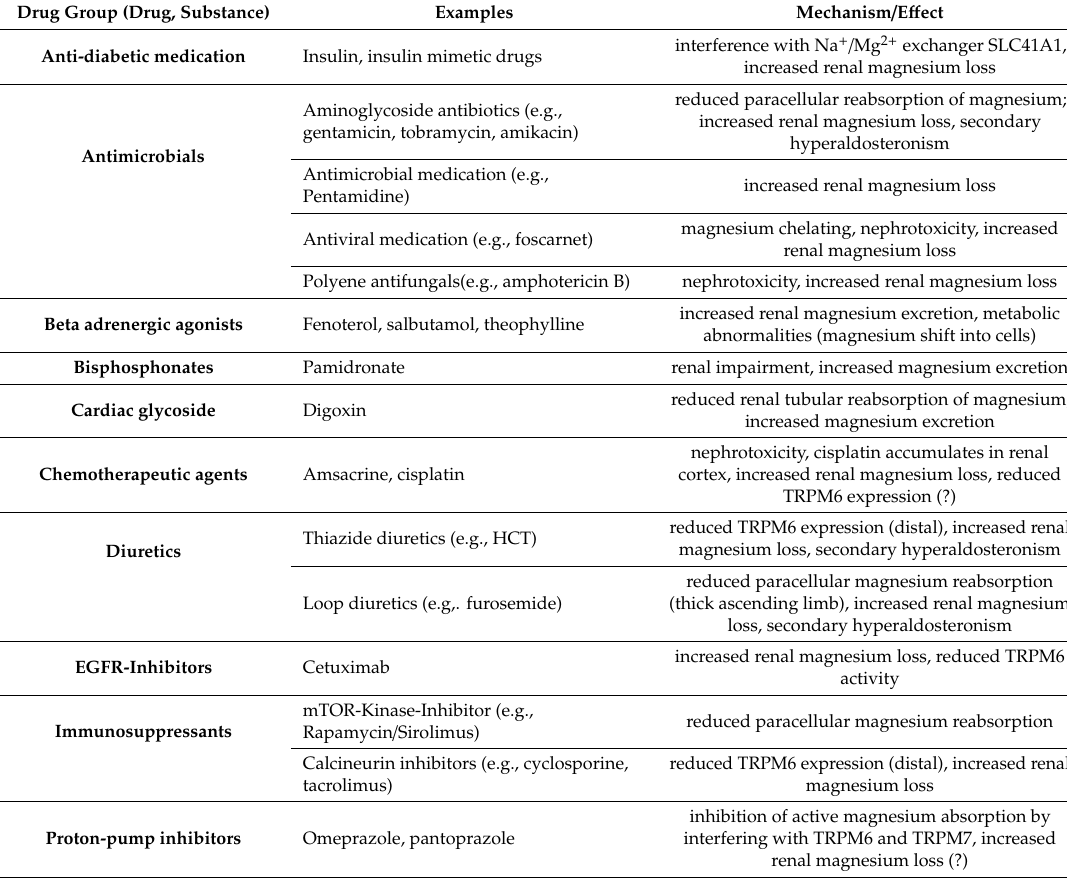
Table 1. Drug-induced magnesium loss and hypomagnesemia